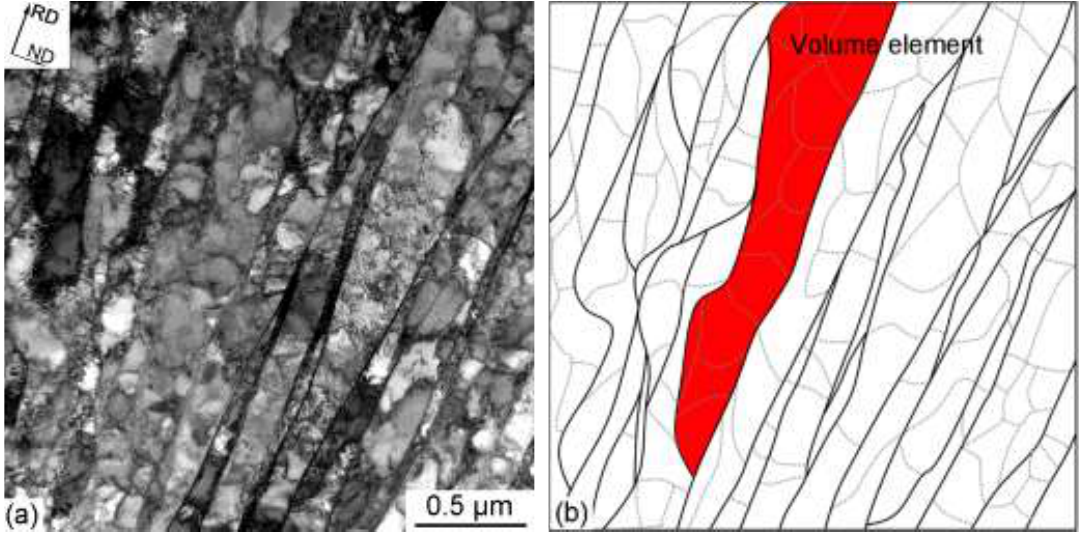
Figure 6. The microstructure of the 90% cold-rolled sample in the longitudinal plane: ( a ) TEM images of the lamellar boundary structure, ( b ) a sketch of the GNBs (solid black lines) and the IDBs (dashed grey lines) in ( a ).